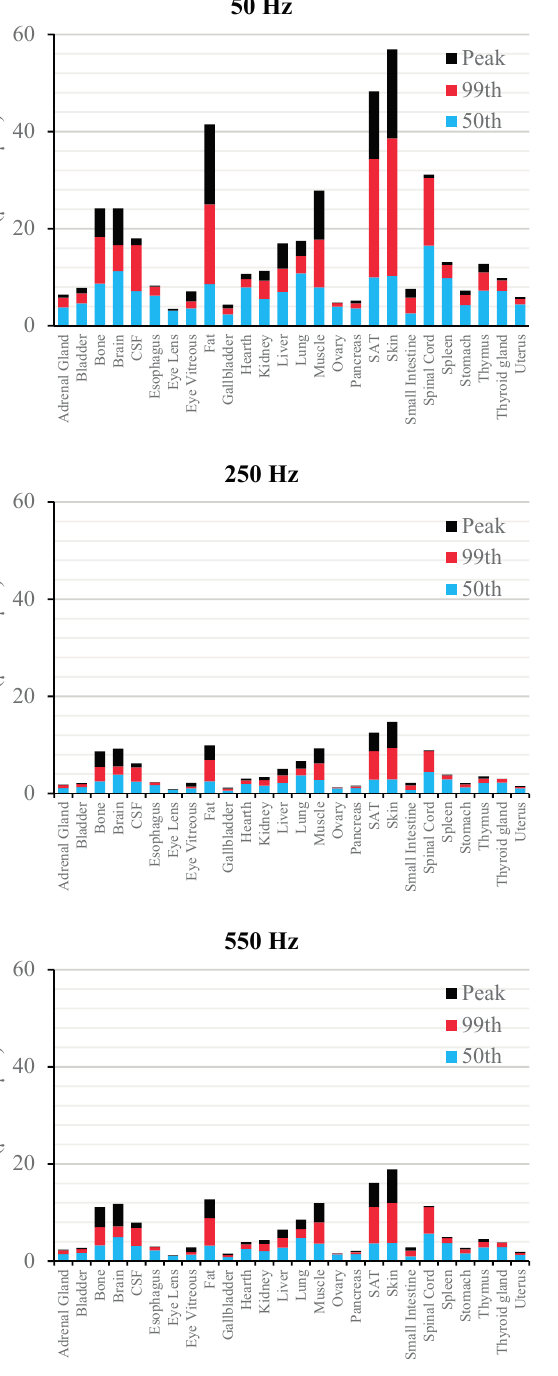
Figure 6. E ( μ V/m) per μ T of 50 Hz B peak induced in foetal tissues at 9 mGA for all the harmonic frequencies considering the standard EN 50160 for the LV&MV power supply networks. The bars indicate the E 50th (blue), the E 99th (red) percentiles and the E peak (black) of each